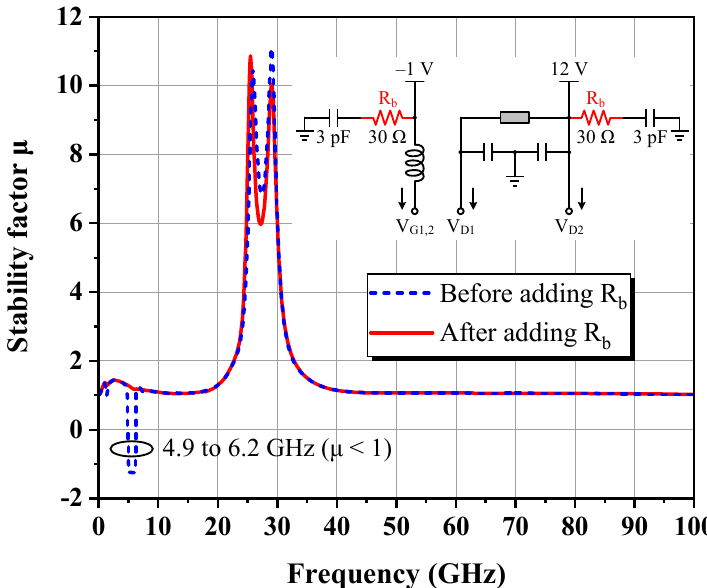
Figure 14. Stability factor μ before and after adding the R b .